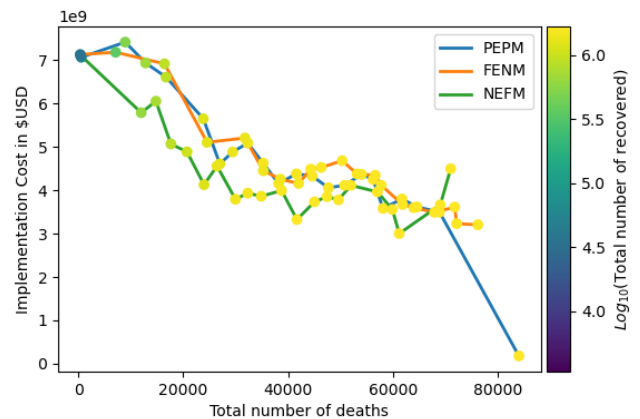
Figure 3. Implementation costs for the Pareto optimal solutions shown in Figure 2 at different death levels, for the three different algorithm variants. Solutions are given by colored dots, where dot colors indicate the number of recovered individuals according to the color scale at